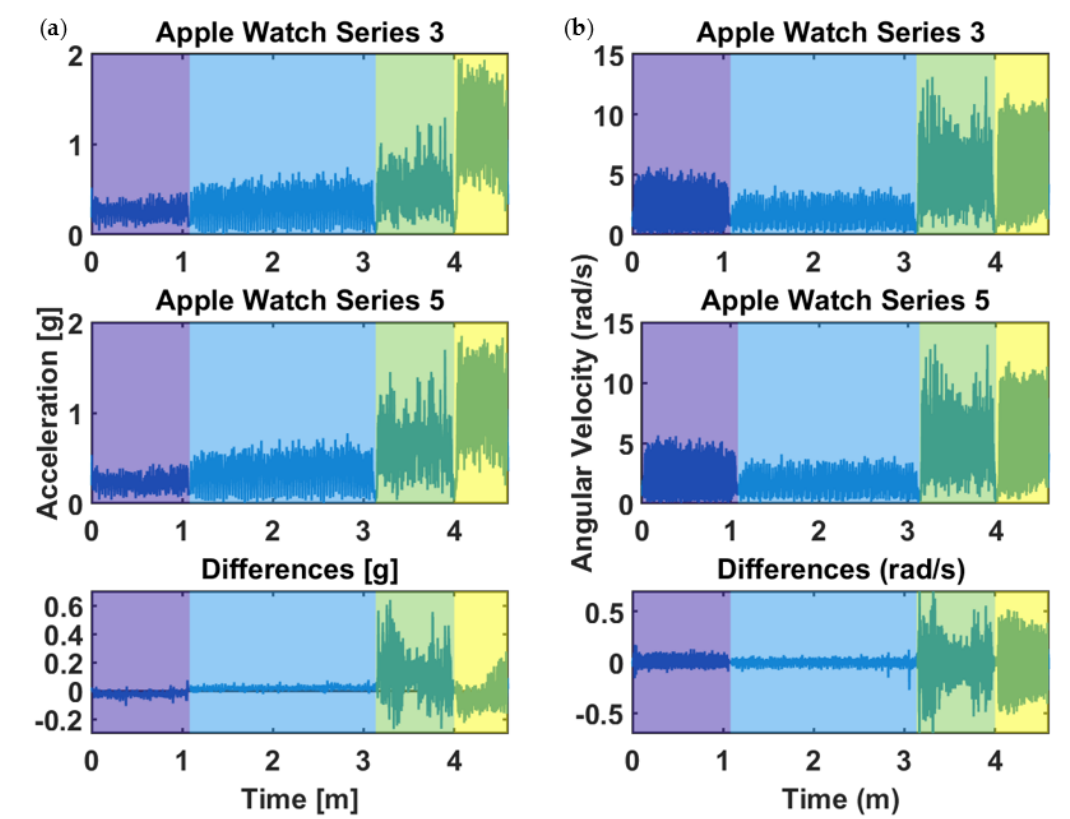
Figure A1. Depicts recorded IMU signal from Apple Watch Series 5 (top of stack) and Apple Watch